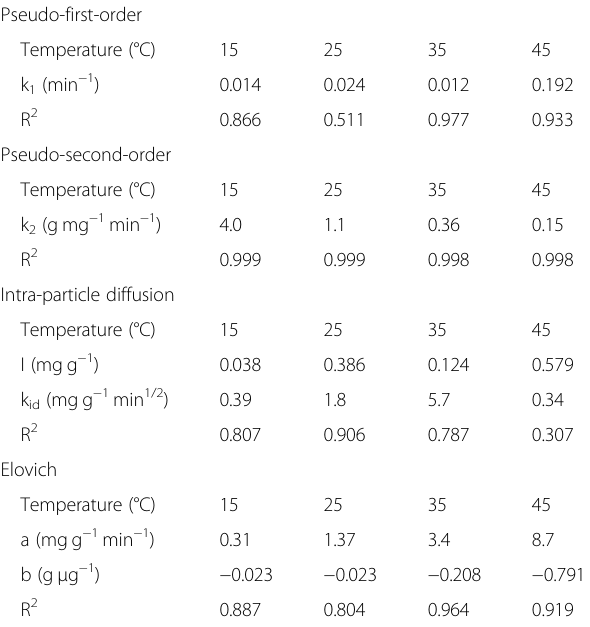
Table 4 The parameter of kinetic models with the addition of 0.1 mM